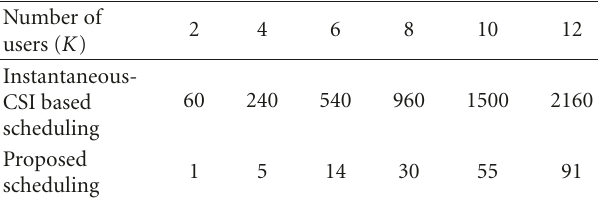
Table 1: Scheduling complexity according to K when T LT = 300 ms and T ST = T Frame =